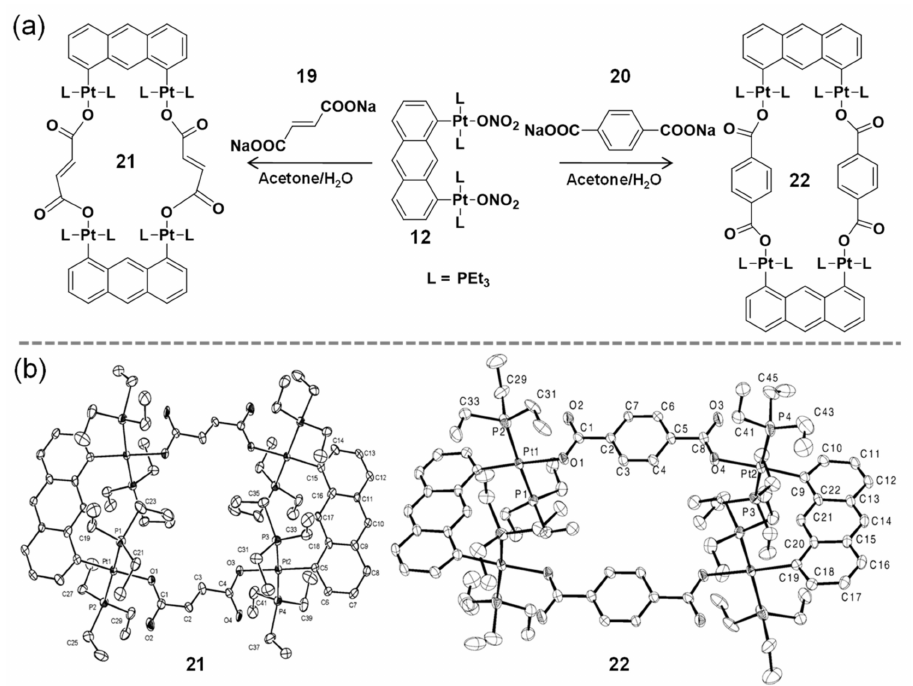
Figure 4. Diplatinum(II)-based anthracene-containing linker 12 for constructing oxygen-based rect- angles. ( a ) The formation of molecular rectangles 21 and 22 . ( b ) ORTEP diagrams of 21 and 22 . Reprinted with permission from Ref. [57]. Copyright 2003 American Chemical